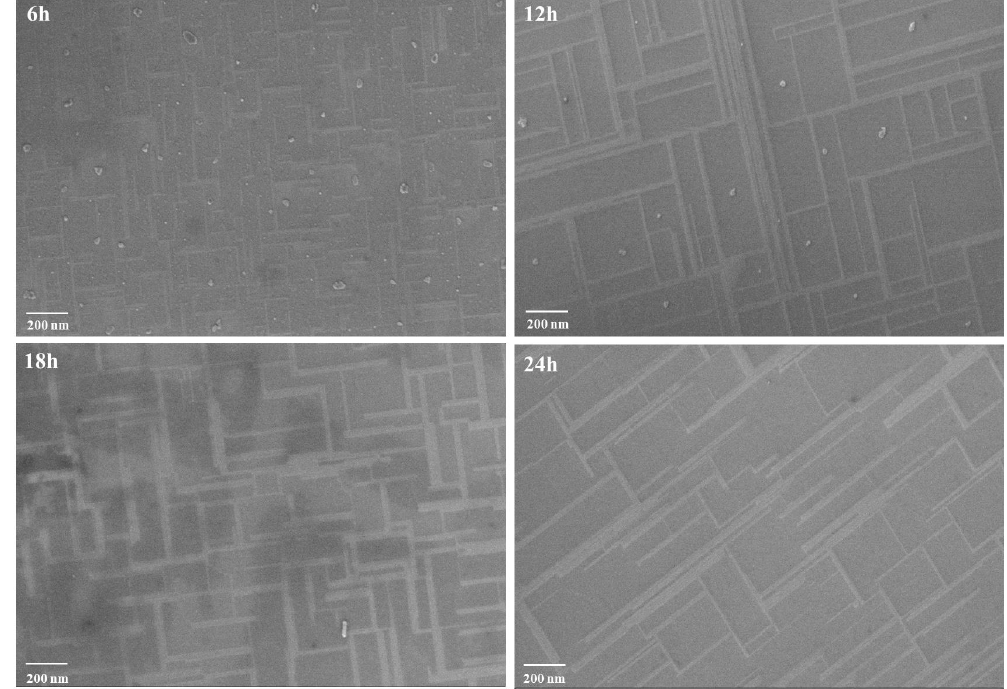
Figure 2. The SEM images of SrTiO 3 single crystals after 6, 12, 18, 24 h annealing.